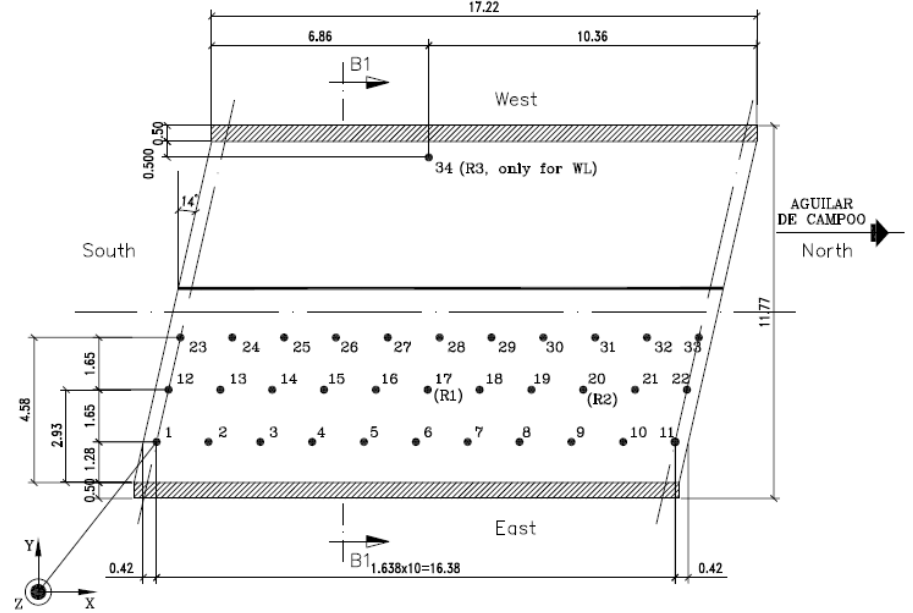
Figure 3. The measurement nodes on the bridge deck, labeled from No. 1 to No. 34, in which the reference ones are denoted by R (units in meters).